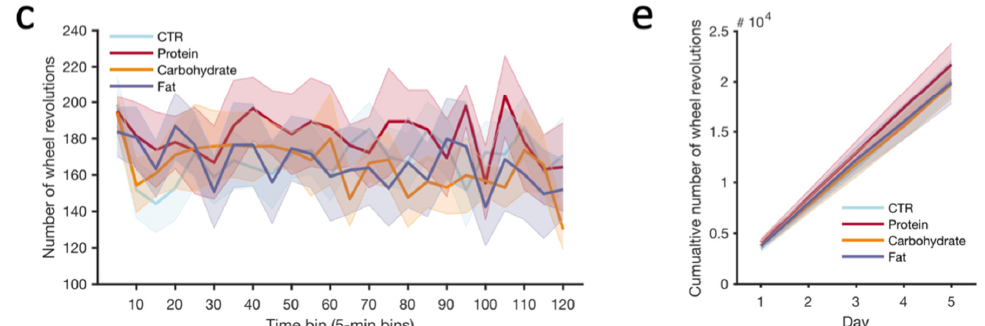
Figure 3. ( a ) Timeline of the habituation and running wheel (2 h daily sessions) under the different dietary modulators. ( b ) Schematic of the low-profile running wheel apparatus used during each session. ( c ) Running wheel activity (5-day average) across a 2 h session for each dietary modulator. ( d ) Running wheel activity (2 h sum) across days for each dietary modulator. ( e ) Running wheel activity cumulated across sessions (2 h sum) and days (5 sessions) for each modulator. # 10 4 indicates the y-scale values are to be multiplied by 10 4 . Values reported as mean ± SEM. N = 9 mice.